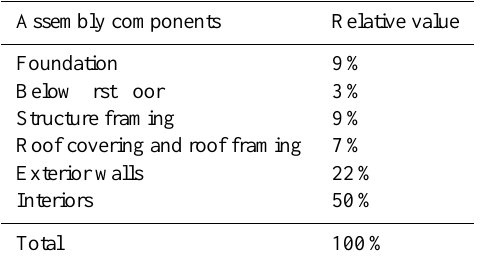
Table 1. Sub-assembly replacement values for the common types of residential buildings as a percentage of the total building replace- ment value (an average estimation based on Rawlinsons construc- tion cost guide (2014) and local construction companies).